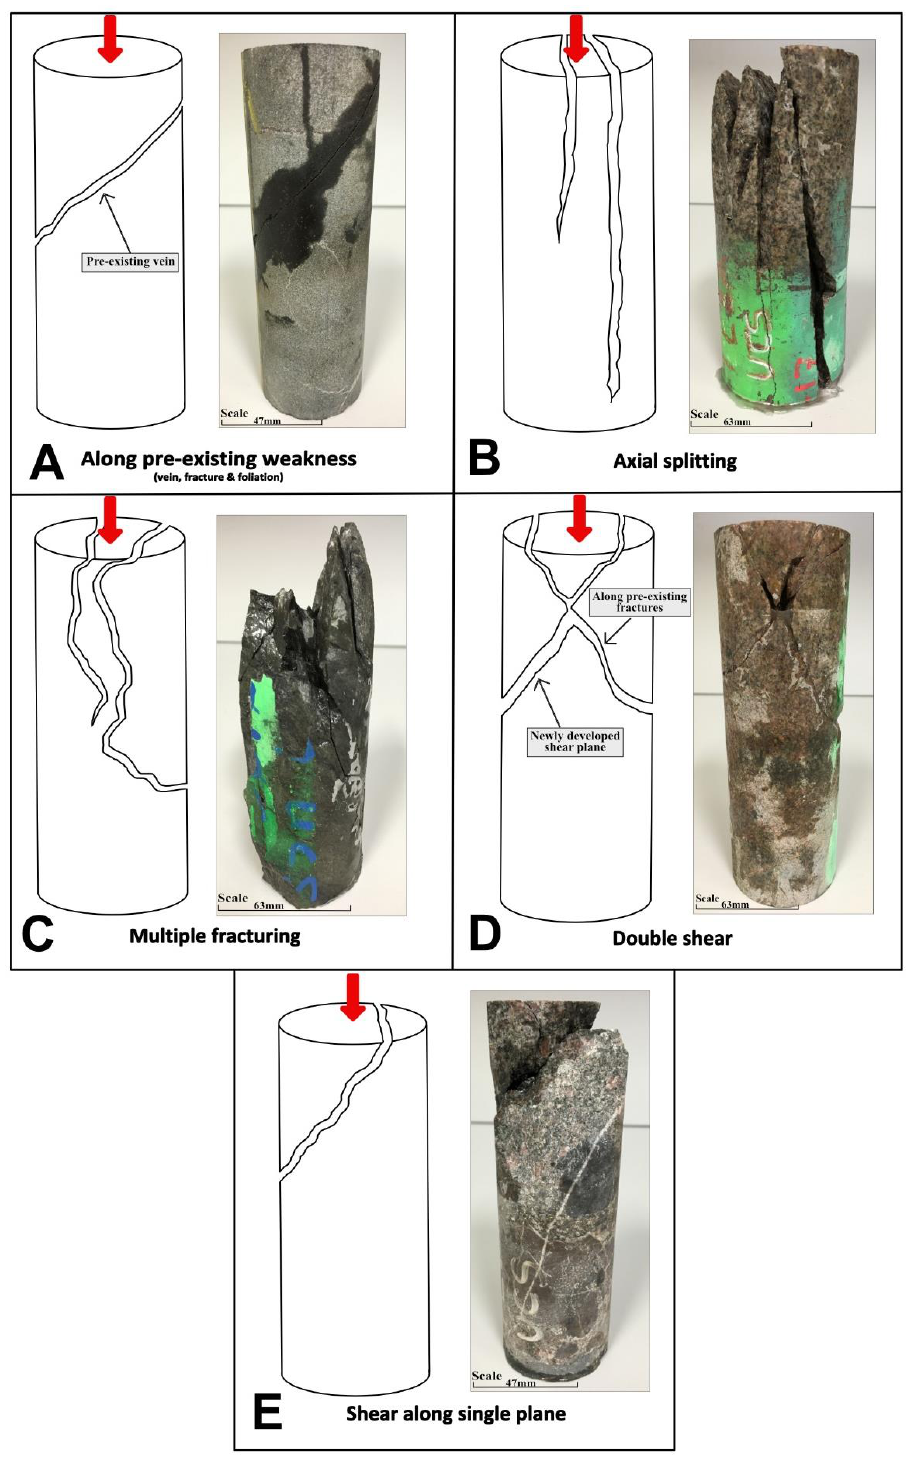
Figure 5. Photographs and schematic drawings showing the failure modes observed during the UCS tests. The red arrows indicate the direction of the maximum principal stress. ( A ) Failure mode along pre-existing weakness (veins, fractures or foliation); sample TE2A. ( B ) Example of axial splitting failure; sample TE3A. ( C ) Example of failure by multiple fractures; sample TE1A. ( D ) Example of failure by double shearing (along pre-existing planes of weakness and newly developed shear planes); sample TE3C. ( E ) Example of failure along a single plane (newly developed failure plane); sample TE2D.